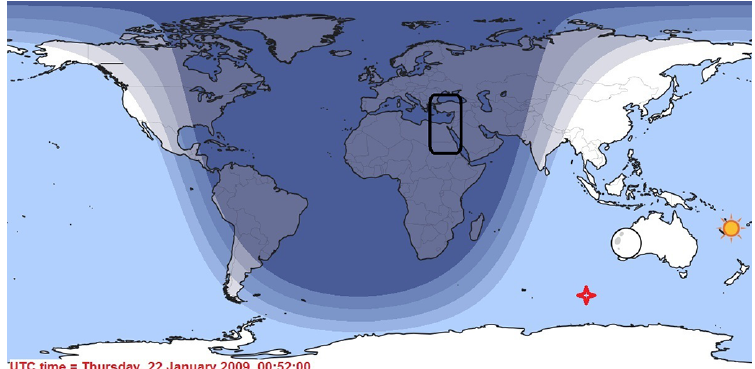
Figure 1. Map shows the solar nighttime and daytime conditions (dark blue and light blue areas, respectively) on 22 January 2009 at 00:52UT, the projection on the surface of the Earth of the Sun’s position (yellow circle), moon’s position (white circle), and the sub-flare point (red star). The black rectangle defines the field of view of CIDR, as indicated by the satellite tracks in Fig.